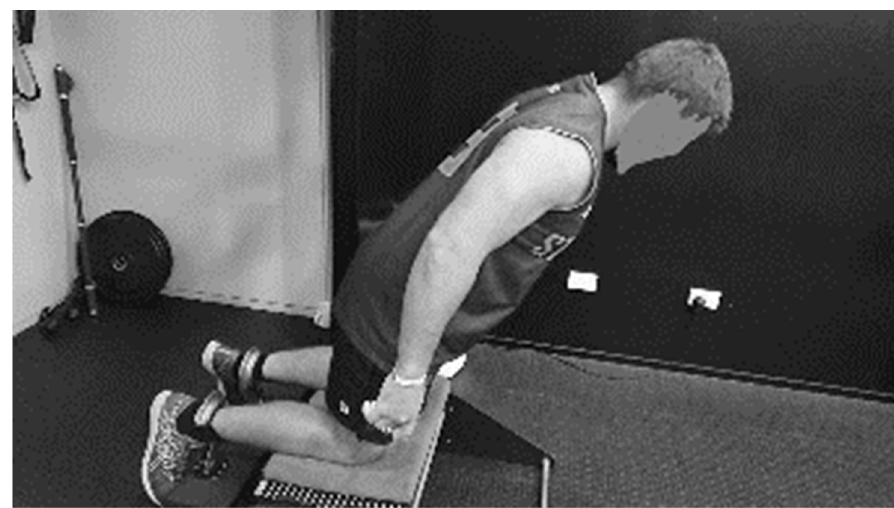
Figure 2. Illustration of Nordic eccentric test performed using a load cell device.